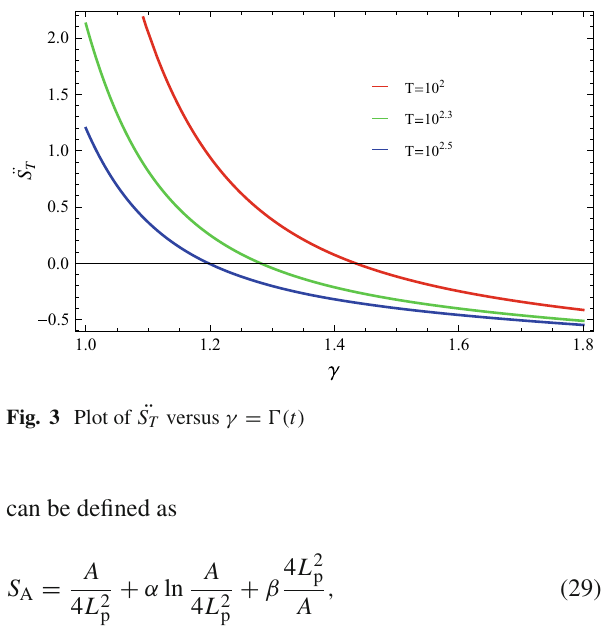
Fig. 3 Plot of ¨ S T versus γ = (cid:2)( t